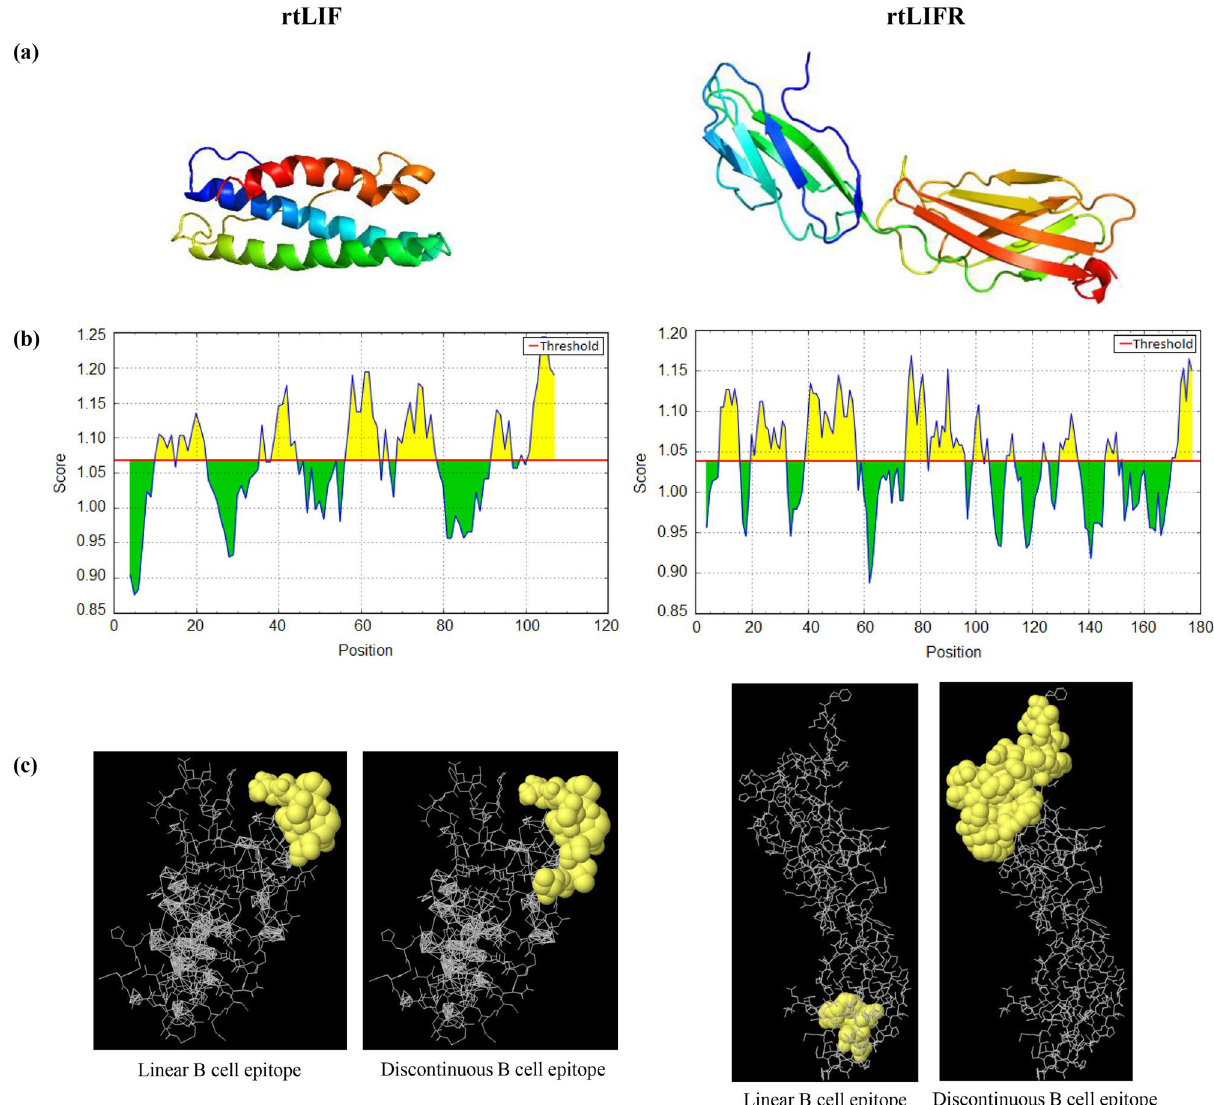
Figure 1. Bioinformatic data of recombinant proteins. ( a ) Prediction of third structure of rtLIF and rtLIFR by Phyre server. ( b ) Kolaskar and Tongaonkar antigenicity prediction tool in IEDB recognized linear B cell epitopes on the rtLIF and rtLIFR. Yellow areas above threshold line were predicted as B cell epitopes. ( c ) Linear and structural B cell epitopes predicted by the Ellipro